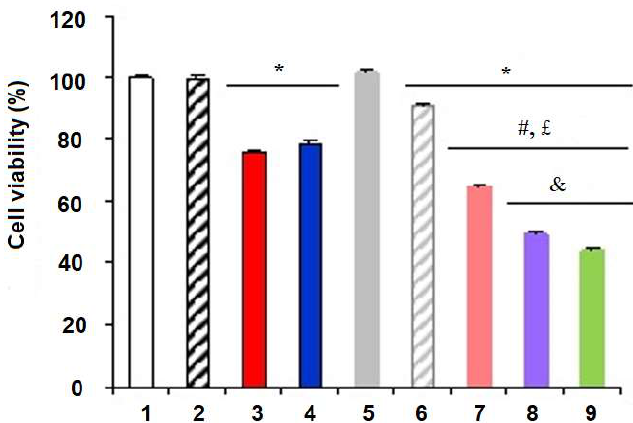
Figure 5. In vitro MCF-7 cells viability determined by MTT test, where ( 1 ) Control 1 (DMEM); ( 2 ) Control 2 (0.1% DMSO); ( 3 ) MTX(OEt) 2 solution; ( 4 ) MTX solution; ( 5 ) LNC + (blank formulation); ( 6 ) Phe-Zn-MLNC (blank formulation); ( 7 ) Phe-Zn-MLNC-MTX(OEt) 2 ; ( 8 ) MTX(OEt) 2 -Zn-MLNC; ( 9 ) MTX-Zn-MLNC-MTX. Data represent the mean ± SD ( n = 3), * p < 0.05 vs. Control (ANOVA, Tukey); # p < 0.05 vs. MTX solution (ANOVA, Tukey); £ p < 0.05 vs. MTX(OEt) 2 solution (ANOVA, Tukey); & p < 0.05 vs. Phe-Zn-MLNC-MTX(OEt) 2 (ANOVA, Tukey).